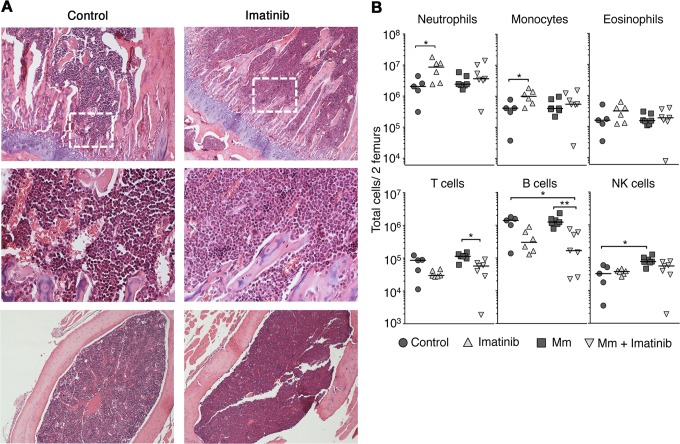
Effects of imatinib on neutrophils and monoctyes in bone marrow.
(A) Geimsa staining of femurs from C57Bl/6 mice administered imatinib at 66 mg/kg/d for seven days or left untreated as indicated. Top panels: coronal sections (10X). Middle panels: Insets (40x) derived from the area denoted by a dashed white box. Bottom panels: sagittal sections (10x). (B) C57Bl/6 mice were administered imatinib at 66 mg/kg/d for seven days or left untreated, as indicated. Beginning 24h after onset of drug, mice were either injected in the tail vein with 105 CFU Mm 1218R or left uninfected. At seven days post-treatment bone marrow was collected from femurs. Data shown are representative of three independent experiments. For all data sets, the line in each group of data points represents the median. A Mann-Whitney test was used for pairwise comparisons, and a Kruskal Wallis test for multiple comparisons.